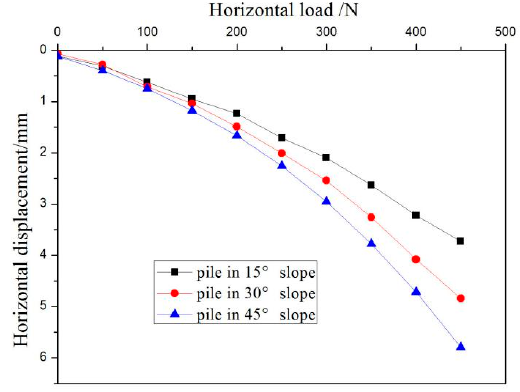
Figure 8. Curves of comparison of the load–displacement on slope piles with different angles.